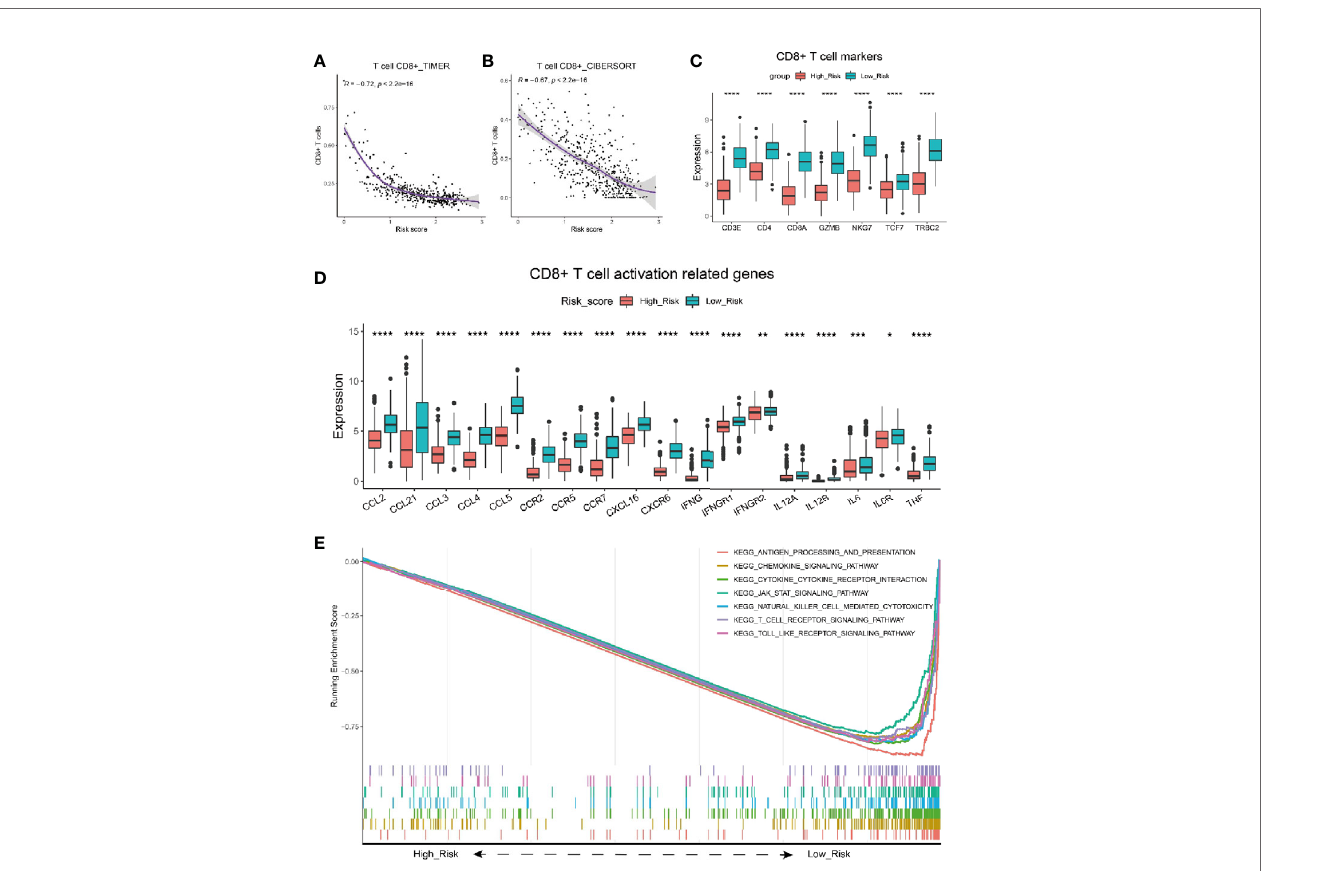
FIGURE 4 | Characterization of risk score with immune activity. (A, B) Correlation between risk score and the in fi ltrating number of CD8 T cells in melanoma patients by analysis with TIMER (A) and CIBERSORT (B) . (C) Comparison of seven T cell marker expression level between melanoma patients with high and low risk scores in the TCGA cohort. (D) Relationship between risk score and CD8+ T cell activation related genes. Adjusted P values were showed as: *P < 0.05; **P < 0.01; ***P < 0.001, ****P < 0.0001. (E) GSEA of gene expression from data sets TCGA_SKCM shows genes involving in CD8+ T cell in fi ltration signaling pathway mostly enriched in melanoma patients with low risk